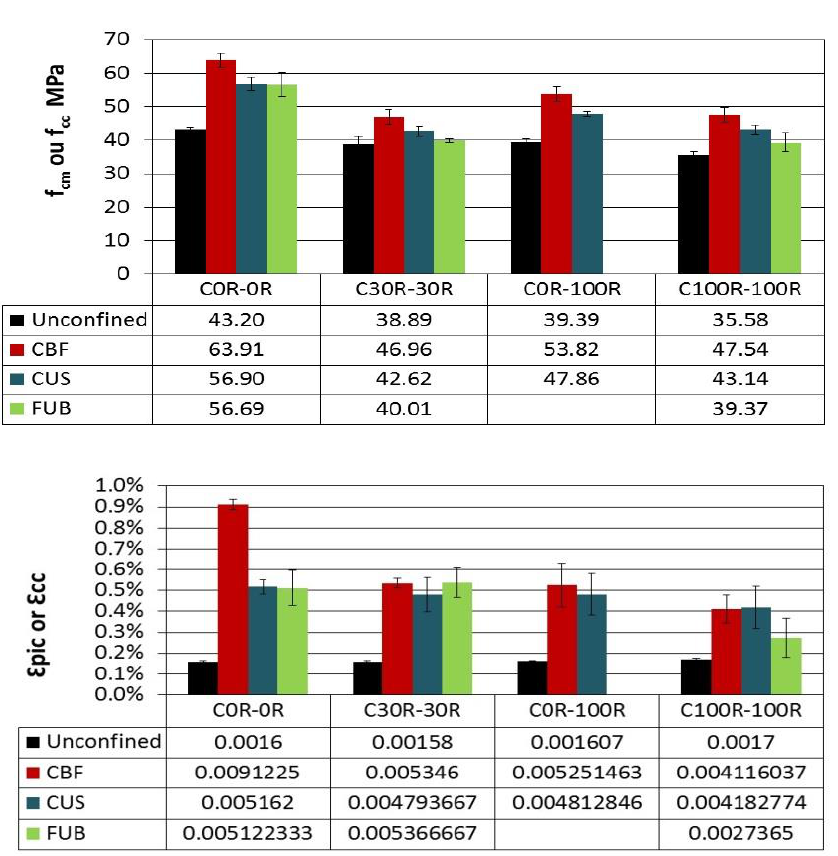
Figure 3. Ultimate strength f cc and ultimate confined concrete strain ε cc of recycled aggregates concretes (RAC) confined by fiber-reinforced polymers (FRP) composites.